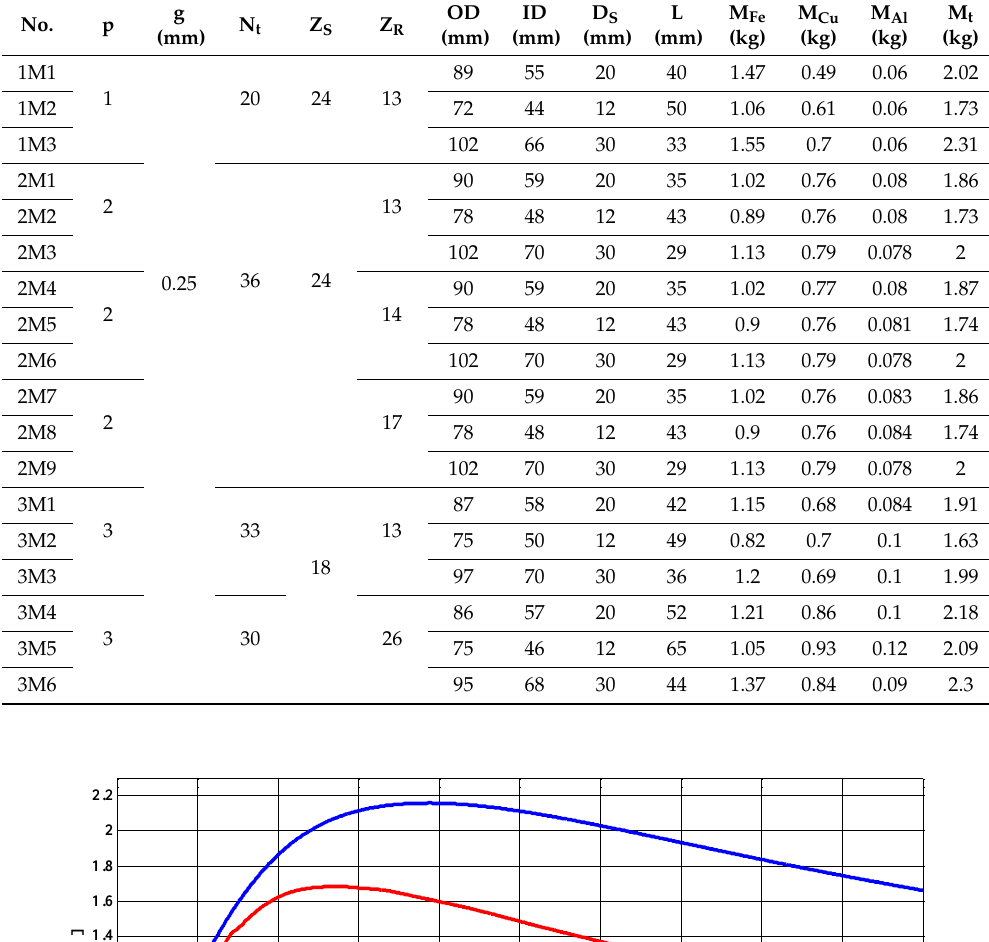
Table 3. Parameters of the initially designed IMs (e = 0).